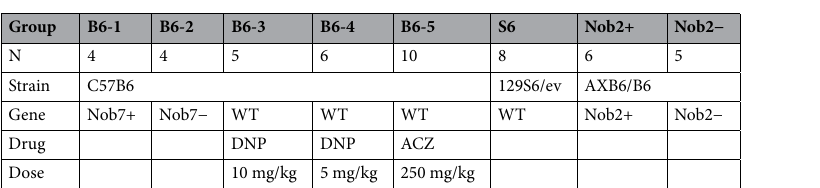
Figure 1. Effect of light and dark adaptation on the HB in outer retina. (A) Example of OCT images captured in light and dark from the same mouse eye. Red arrows point the HB between photoreceptor tip (PRT) and retinal pigment epithelium (RPE) layers. NFL nerve fiber layer, IPL inner plexiform layer, INL inner nuclear layer, OPL outer plexiform layer, ONL outer nuclear layer, ELM external limiting membrane, IS/ep inner segment/ellipsoid layer. (B) Representative intensity profiles averaged from all four radial scans of the eye in (A) for images captured in light (red) and dark (blue). HB is marked by a bar on left side. (C) Magnified view of HB. The dashed line represents the baseline constructed by connecting the maximal intensity for photoreceptor tip layer and RPE layer (Supplemental Figure S2) and rotated to horizontal. The intensity profiles are shifted laterally with center aligned for light and dark conditions. HB magnitude is calculated as the peak distance from the baseline line; HB width is measured as length between two half maximal points. Normalized light–dark responses of HB magnitude (D) and width (E) were made from 5 C57BL/6J mouse groups (Table 1) and one 129S6/ev group under light and dark conditions. Values are normalized by standard deviation of each mouse group. An asterisk indicates the credibility interval excludes 0 (equivalent to statistically significant).